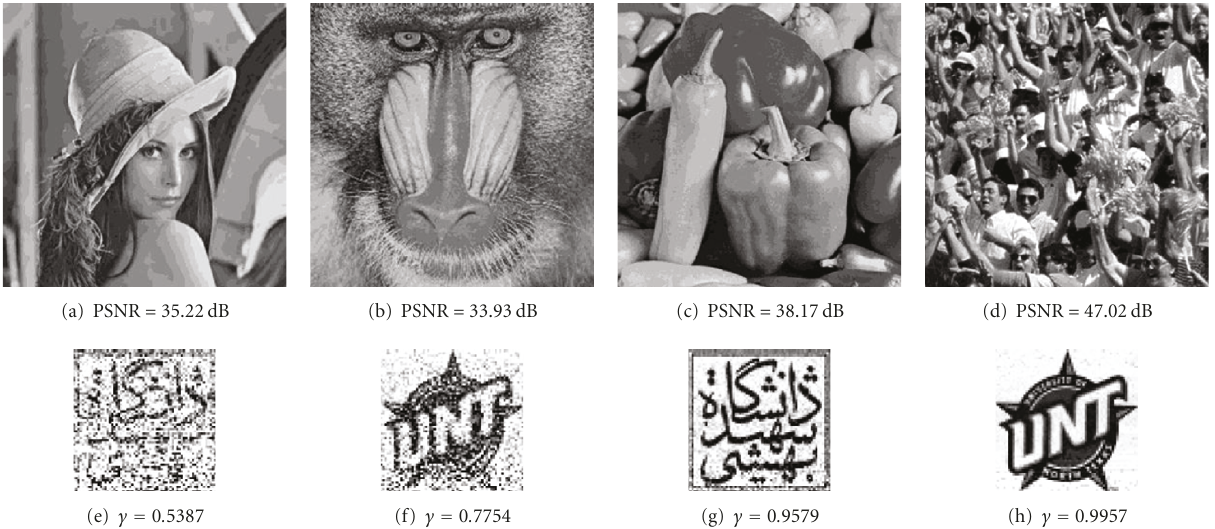
Figure 16: (a)–(d) The watermarked Lena, Baboon, Peppers and Crowd images with 256 × 256 watermark image after wavelet compression with quality factor 0.4bpp, 0.8 bpp, 1.5bpp and 3.5 bpp, respectively. (e)–(h) The extracted watermarks (256 × 256) from (a)–(d),